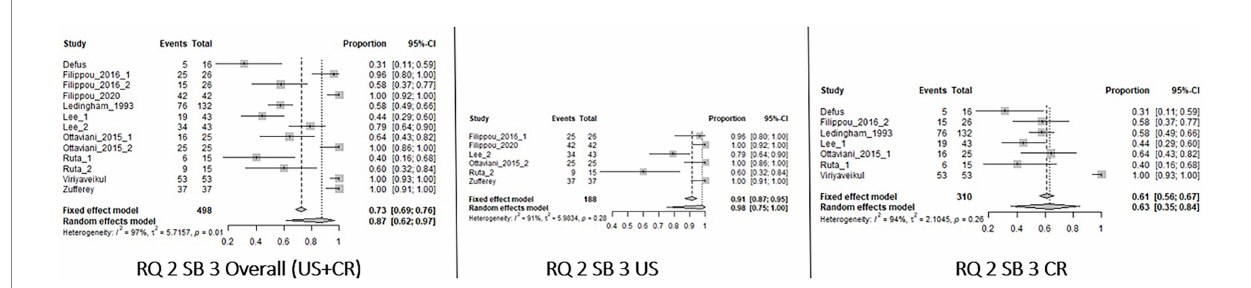
FIGURE 5 Forest Plot Knee, Research Question 2 (RQ 2), Sub-analysis 3: patients with suspected CPPD diagnosis and reference standard different than imaging, analyzed by